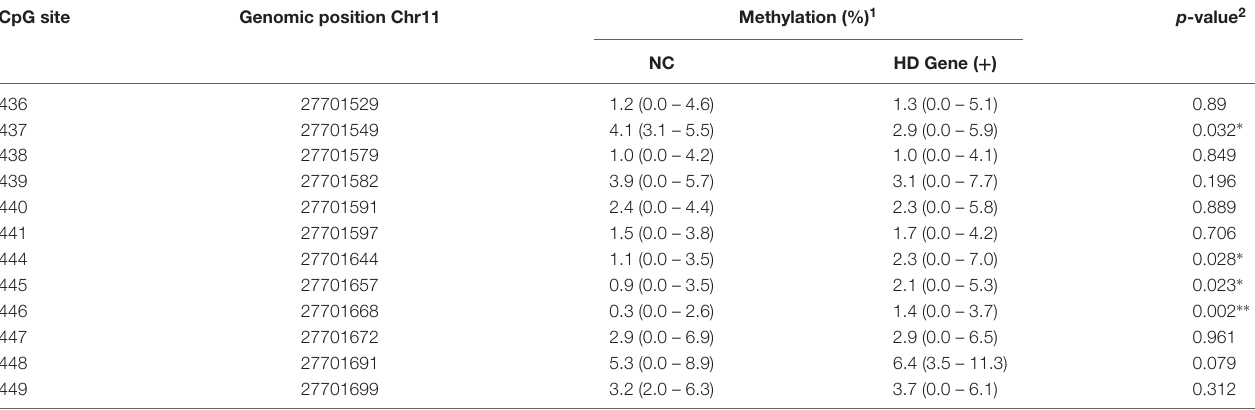
TABLE 4 | DNA methylation status at selected CpG sites from BDNF promoter IV.